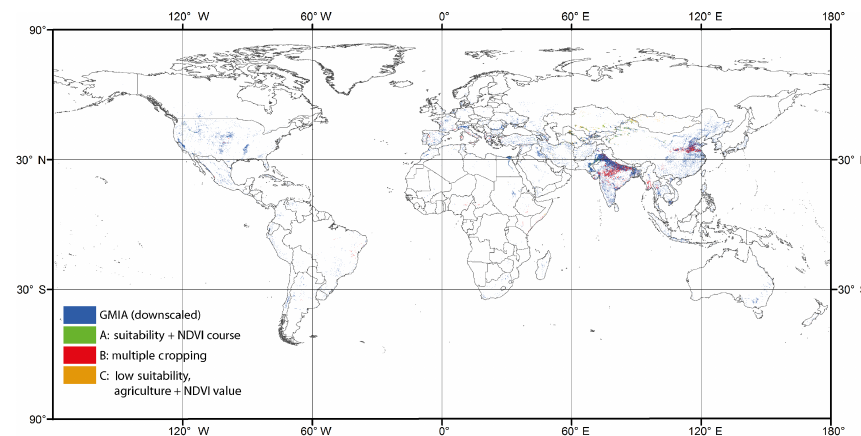
Figure 4. Irrigated areas identified by different approaches.